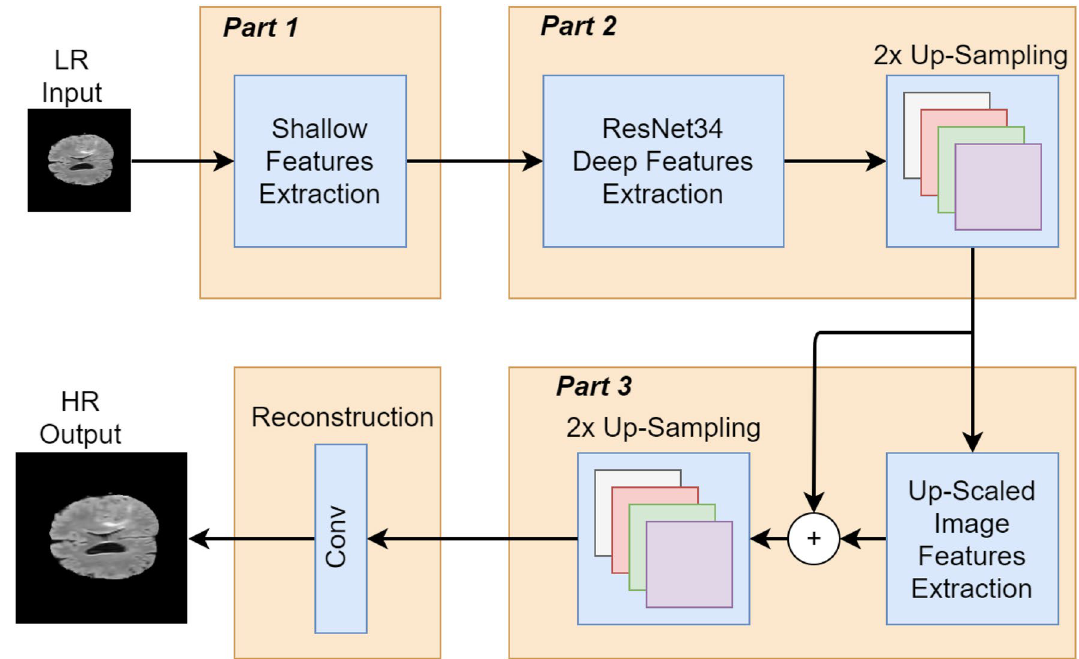
Figure 1. An overall block diagram to show the two rounds of the features extraction and 2x